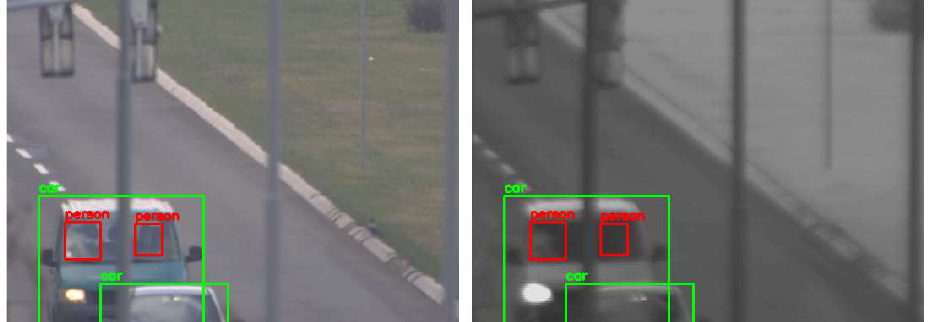
Figure 11. An example of people detection mapping from color to SWIR image, although people in the car are not clearly noticeable in the SWIR image due to the nature of the SWIR sensor.